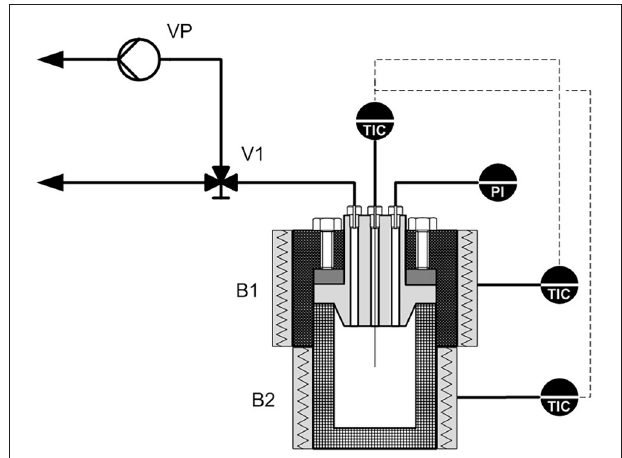
FIGURE 1 | Schematic of the experimental set-up. B1, B2, electrical bands; PI, pressure gauge; TIC, temperature gauge; V1, three-ways valve; VP, vacuum